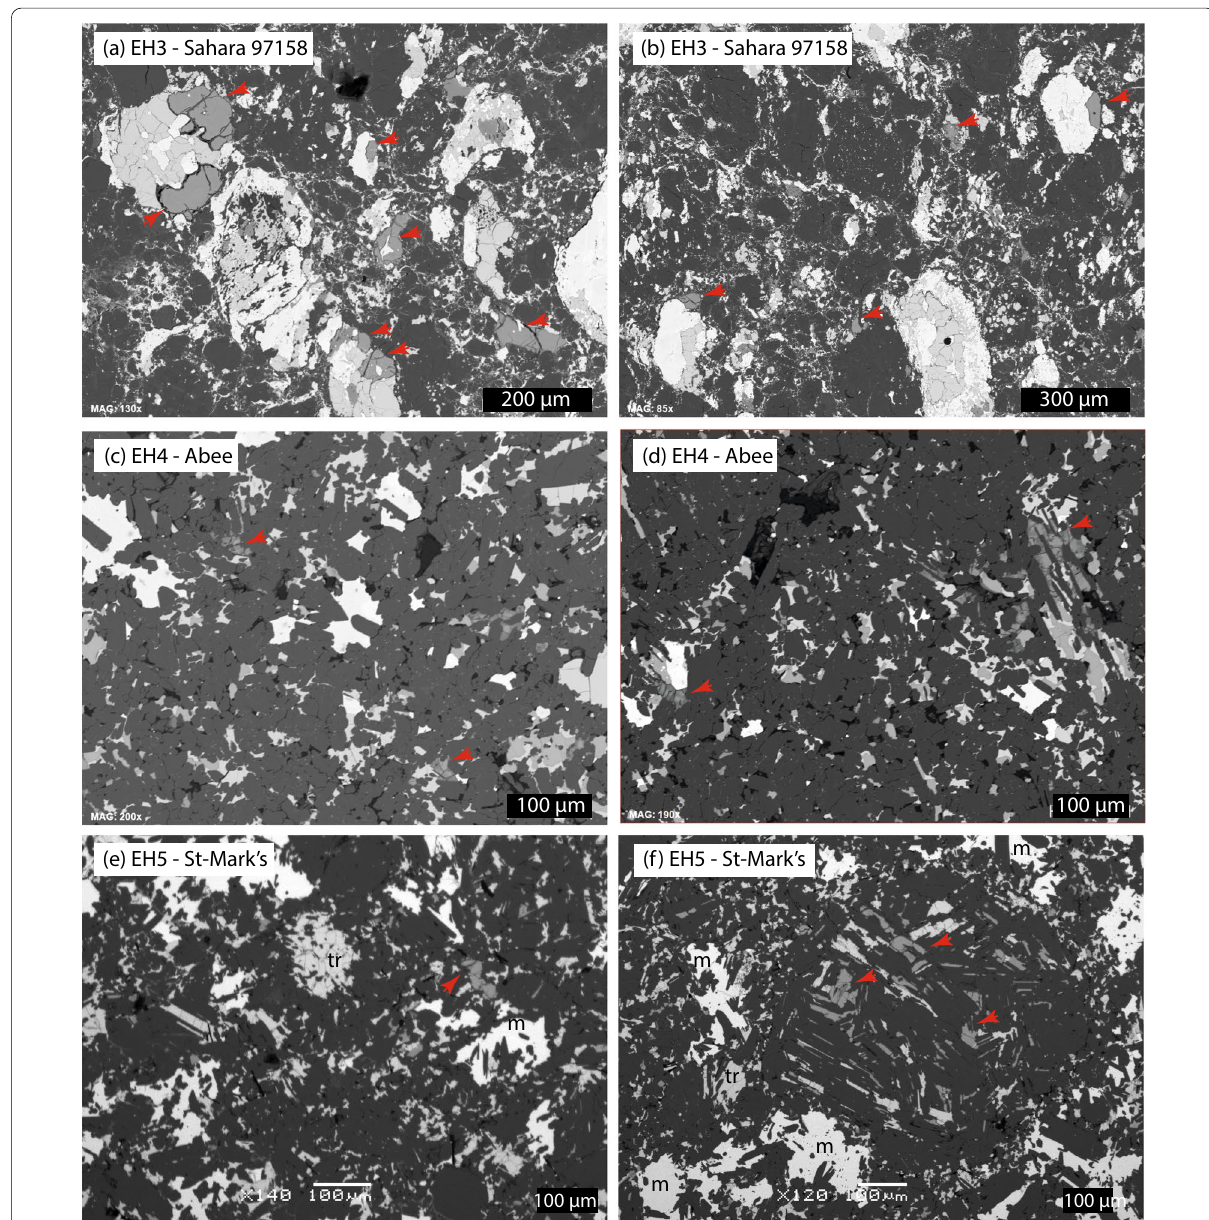
Fig. 2 Scanning electron images of some of the EH samples studied, illustrating the textural position of the oldhamite grains, indicated by the reds arrows. Also indicated are the metal (m) and troilite (tr)